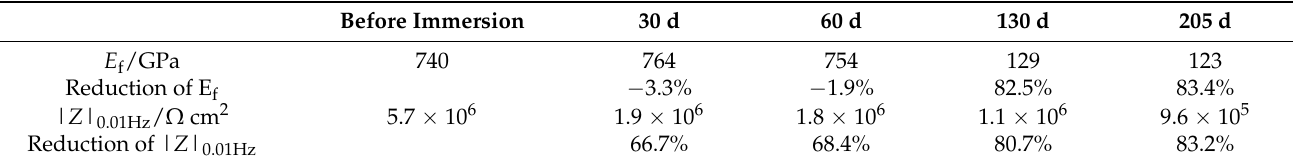
Table 3. E f results of T700/VE composite specimens after immersion at different